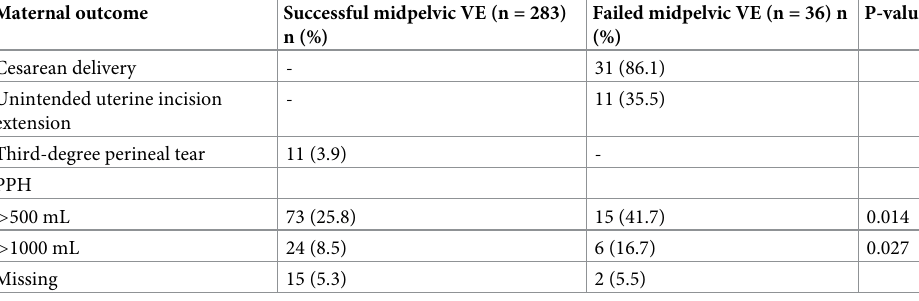
Table 4. Maternal outcome in attempted midpelvic vacuum extractions (n = 319) categorized according to success or